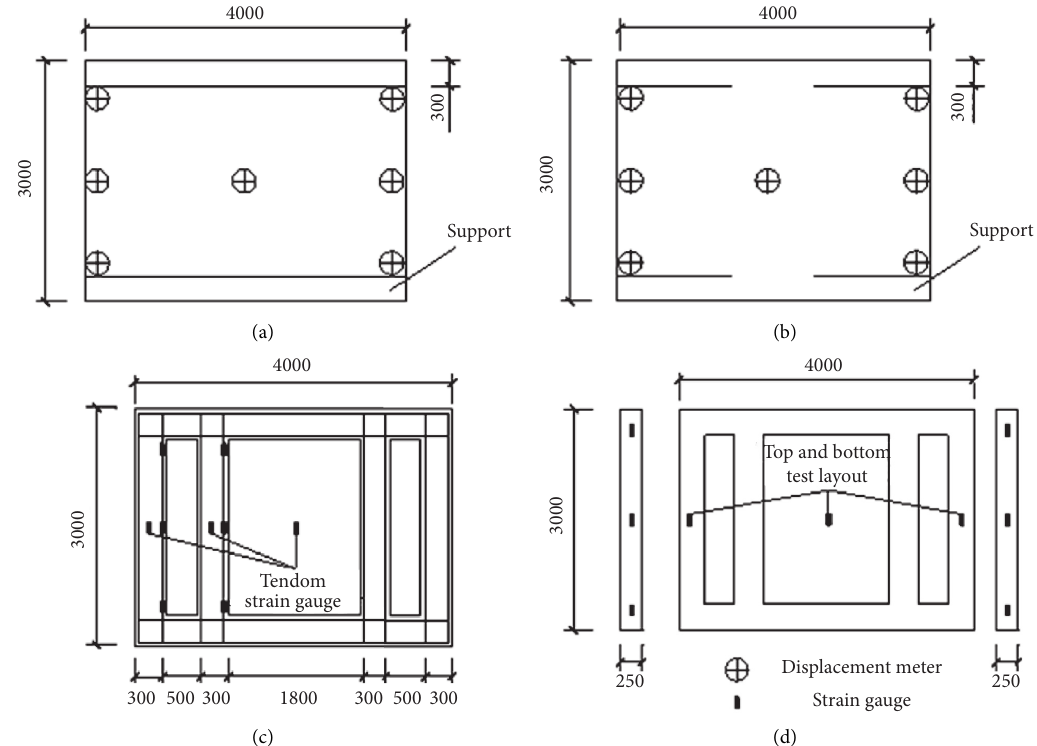
Figure 3: The arrangement of strain gauges and displacement meters (dimensions in mm): layout of the displacement meter on (a) the top of the specimen and (b) the bottom of the specimen; (c) rebar strain measurement point layout; and (d) layout of concrete strain measuring points.